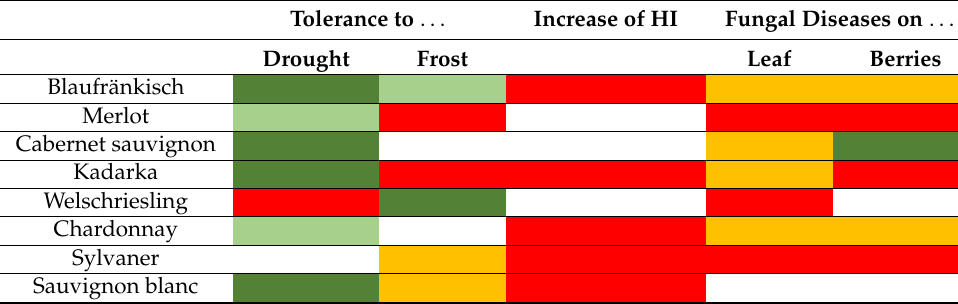
Table 2. Climate sensitivity of the most popular grapevine varieties. Tolerance to . . . Fungal Diseases on . .